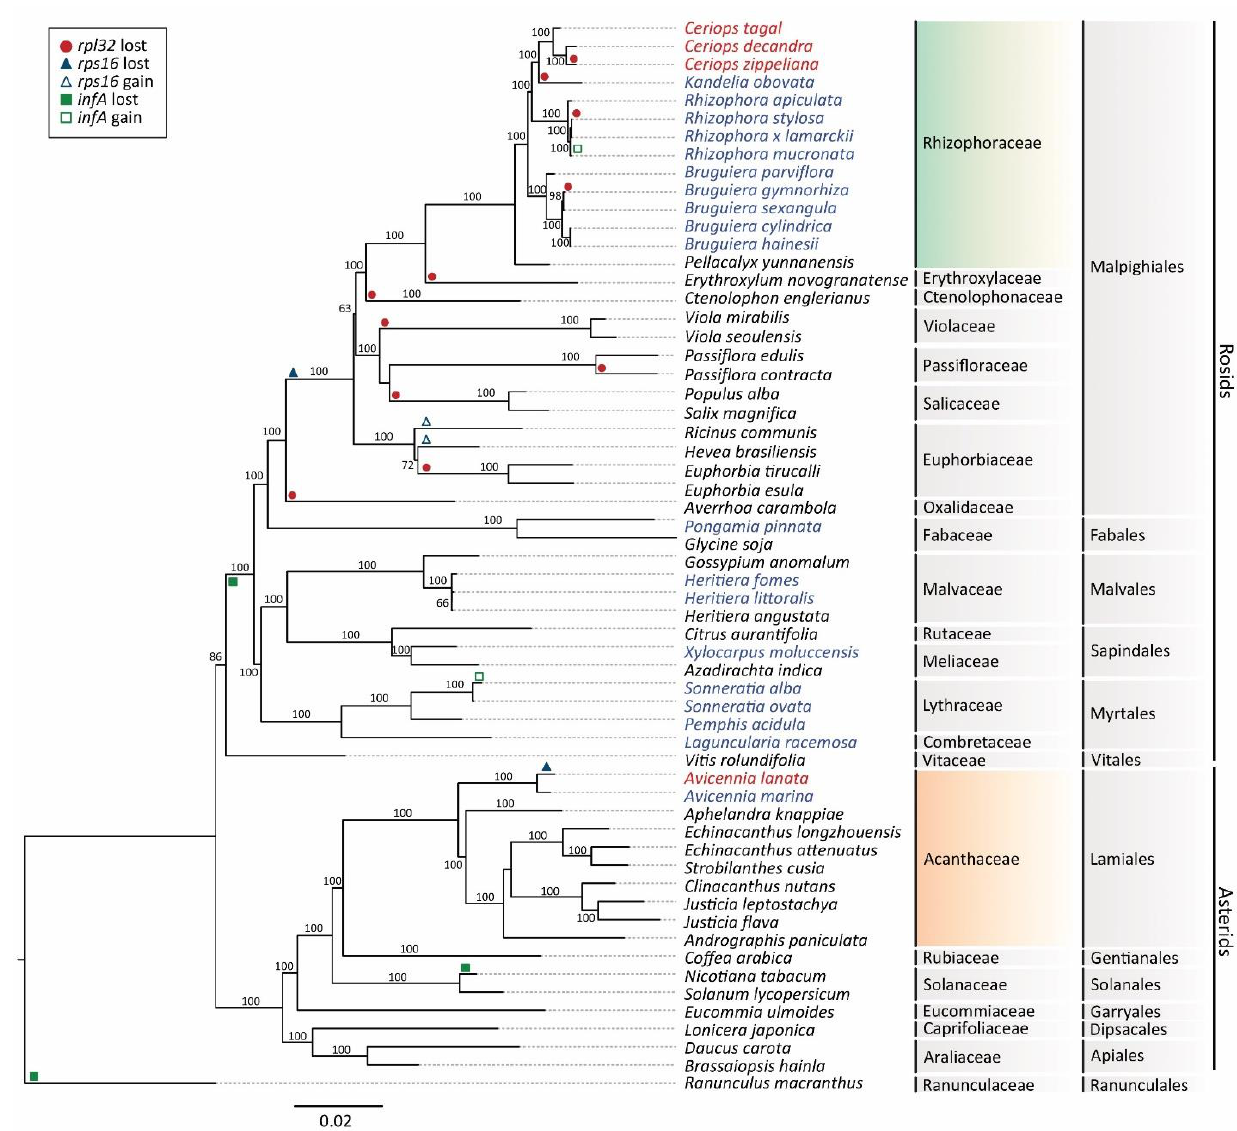
Figure 6. Maximum likelihood (ML) tree for 50 chloroplast protein-coding genes in 59 plant species. Values above the branches represent bootstrap with 1000 replicates. The mangrove species in this study are indicated in red text, whereas other mangrove species are indicated in blue text. The Rhizophoraceae lineage is indicated in gradient green, and the Acanthaceae lineage is indicated in gradient orange. Gain and loss of the rpl32 , rps16 , and infA genes are shown in different symbols and colors.